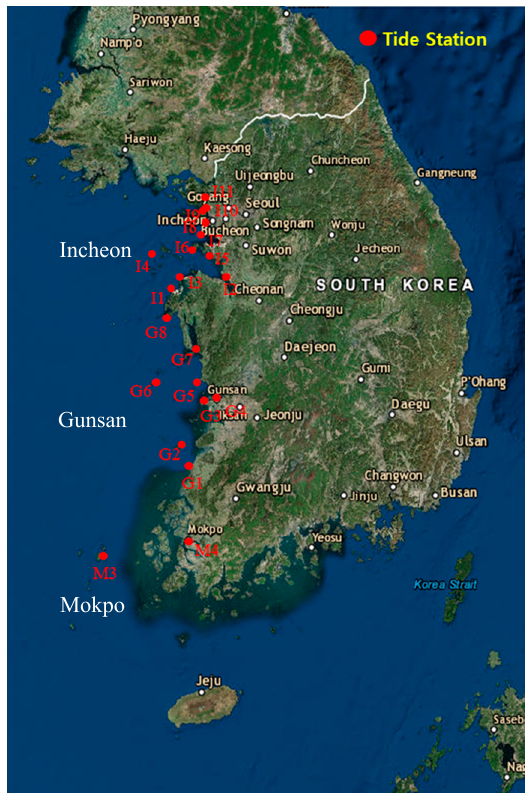
Figure 6. Tidal gauge locations in the WCK selected for the evaluation of the modeling; three sub-regions: Mokpo (M), Gunsan (G) and Incheon (I) Regions.